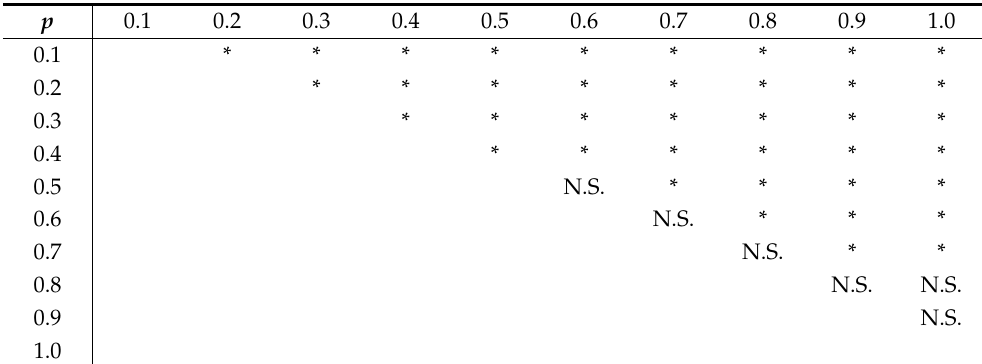
Table 6. Statistical significance in roughness perception for w -constant samples with various p values. * Significance level < 0.05. N.S. means not significant.